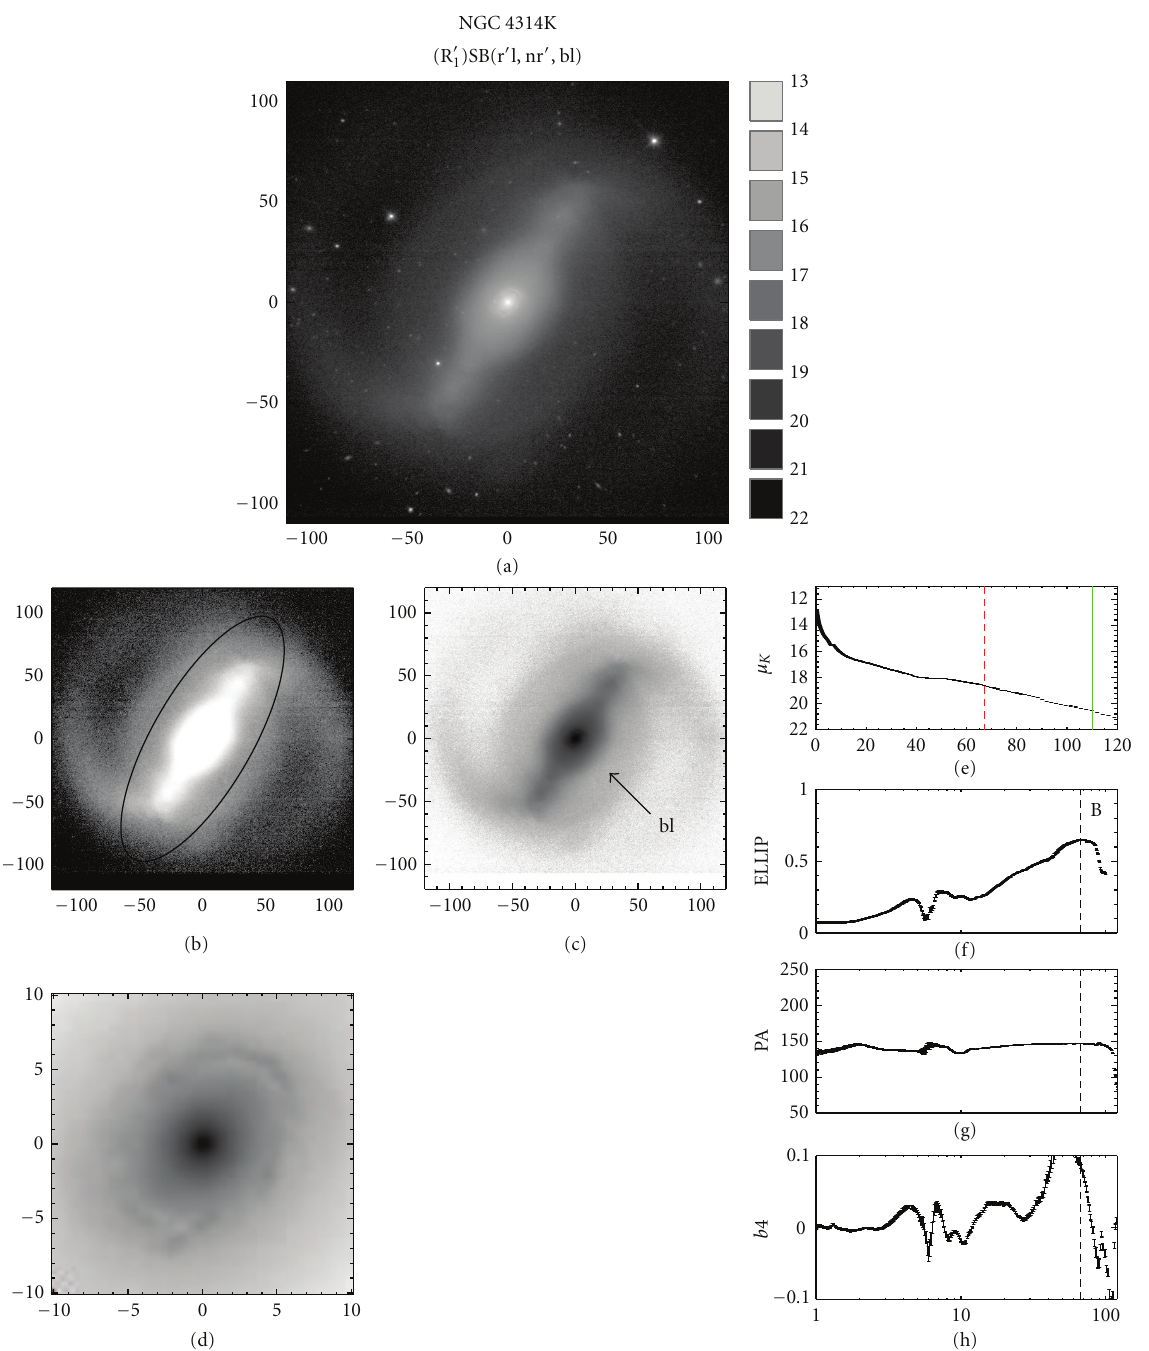
Figure 1: An example of the atlas image [25]. Figure (a) shows the whole galaxy using the full magnitude range, for which the scale is indicated in the right. The scales in x- and y-axes are in arcseconds. The small subfigures show the same image, but selecting the radial and magnitude scales in a di ff erent manner: (b) and (c) use the full radial scale, whereas in (d) only the central region of the galaxy is shown. The morphological classification is from the Atlas paper. The arrow indicates the barlens. The graphics show (e) the radial profile of the surface brightness, (f) ellipticity, (g) position angle, and (h) parameter b4, indicating deviations from perfect ellipticity. The logarithmic radial scale is in arcseconds. In these plots the vertical dashed lines indicate the bar radius, and the full line is the radius where the surface brightness is 20mag arcseconds − 2 . The ellipse in figure (b) corresponds to the 2MASS K 20 isophote. Originally the figure appeared in Laurikainen et al.